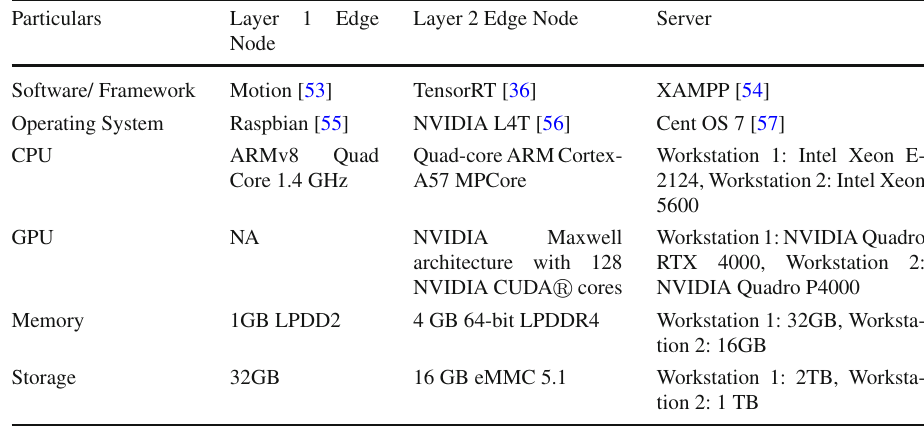
Table 3 Layer-wise technical specification for CVAF